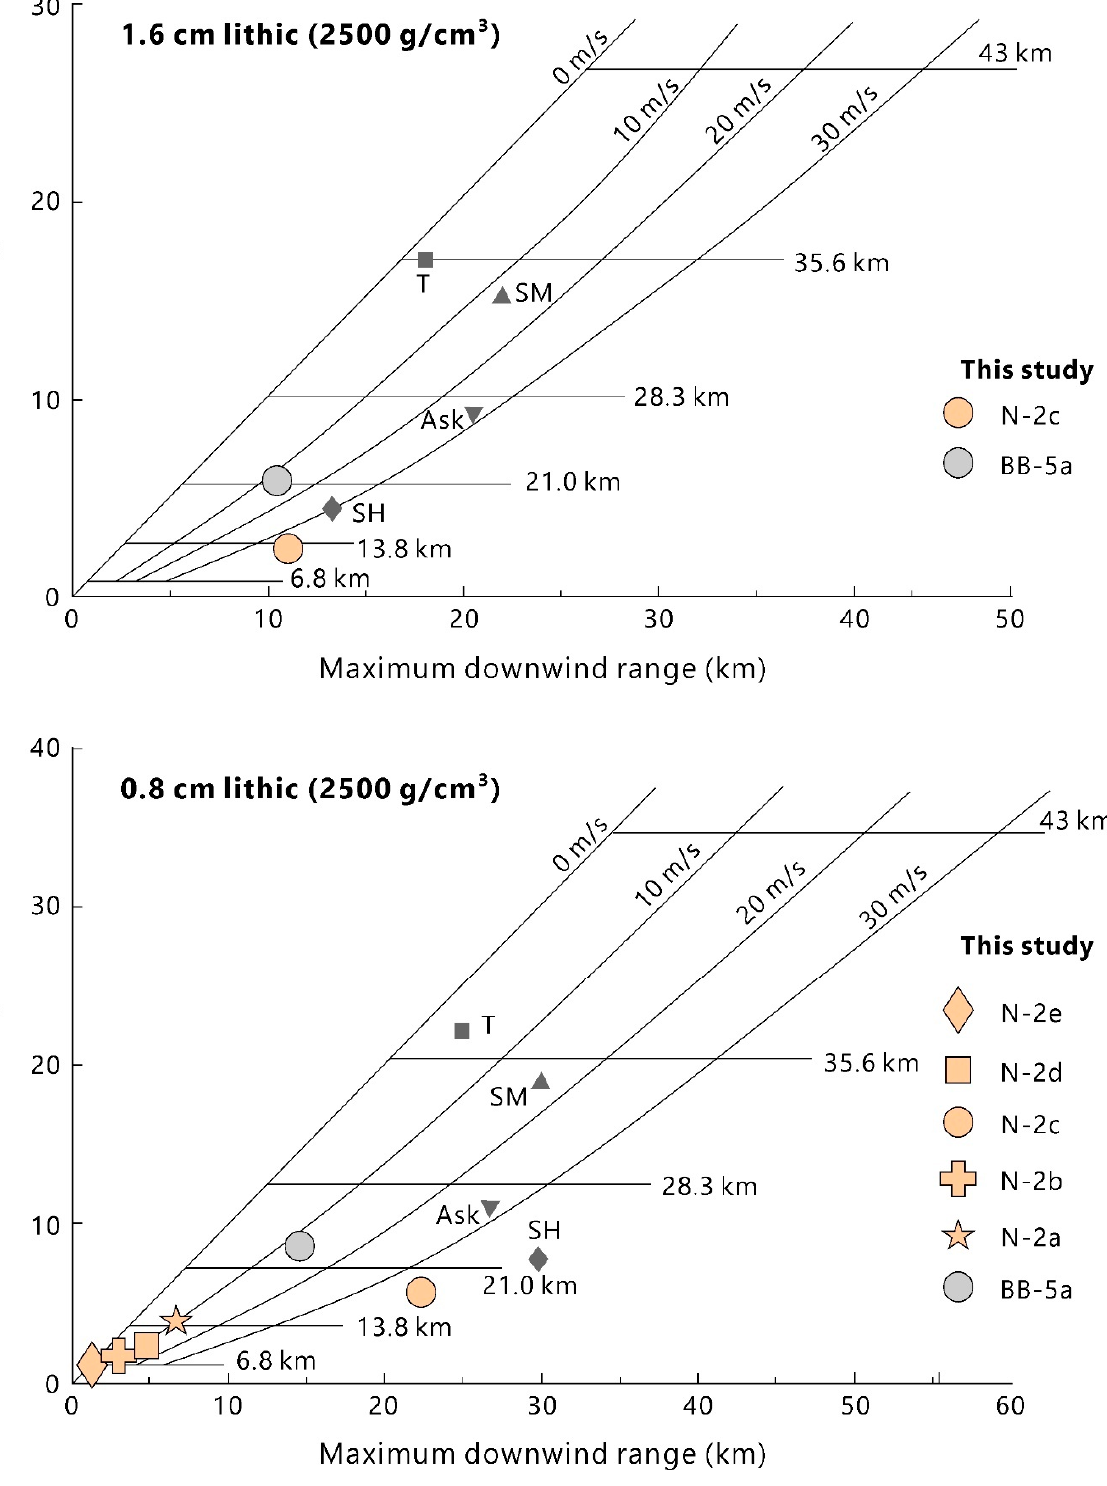
Figure 11. Estimated column heights and wind velocities for Banda Besar and Naira pumice fall, using the methods of Carey and Sparks 1986 [15]. Grey square, triangle, reversed triangle, and diamond corresponds to the eruption of Tarawera in 1886 CE, St. Maria in 1902 CE, Askja in 1875 CE, and St. Helens in 1980 CE [15].